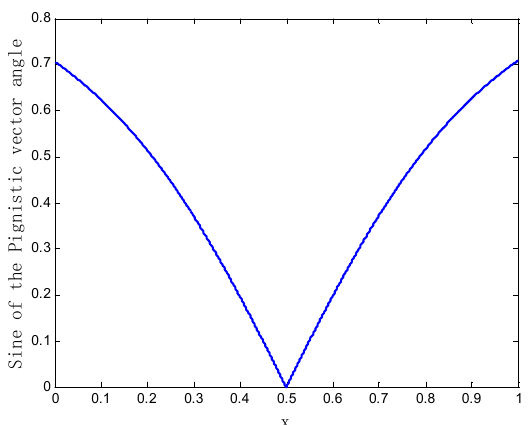
Figure 2. The variation curve of the sine value of Pignistic vector angle between the evidence.